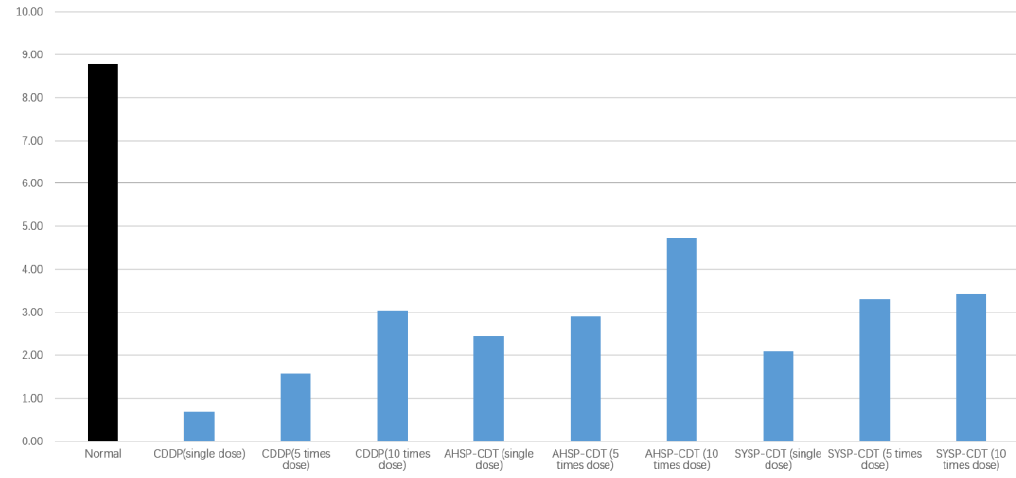
Figure 14. The total value of the blood circulation promotion effect of compound Danshen preparations based on multi-index comprehensive index value.